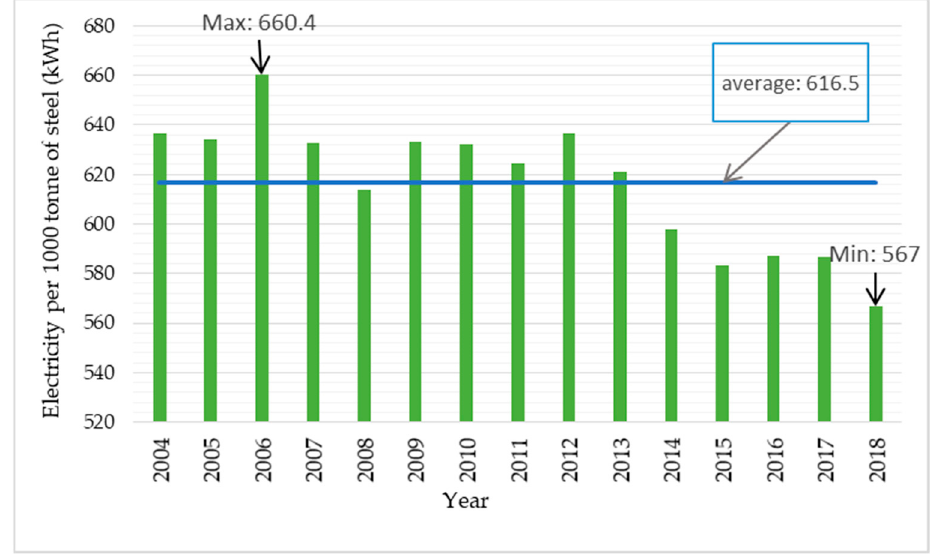
Figure 3. Unit electricity consumption in steel production in Poland from 2004 to 2018. Electricity consumption is higher in the production of steel in the EAF process instal- lation than in the BF + BOF installation (Figure 4). For comparison, in 2004 the electricity consumption of EAF technology was 6.4 times higher than in the BF + BOF technology. In 2018, electricity consumption of EAF technology was 3.6 times higher than in BOF. In 2004–2018, electricity consumption in the steel production process using EAF technology decreased by 19.89%. Figure 4. Electricity consumption by process in Polish steel industry from 2004 to 2018. 4.1.2. Coke Intensity The second analysed resource was coke, which is the main fuel for BF technology. Figure 5 shows the unit coke consumption by BF technology. On the basis of the analysis, it was found that to produce 1 tonne of steel (pig iron), about 0.5 tonnes of coke are con- sumed. With BF technology, the average unit coke consumption in the analysed period was 0.48 tonnes.